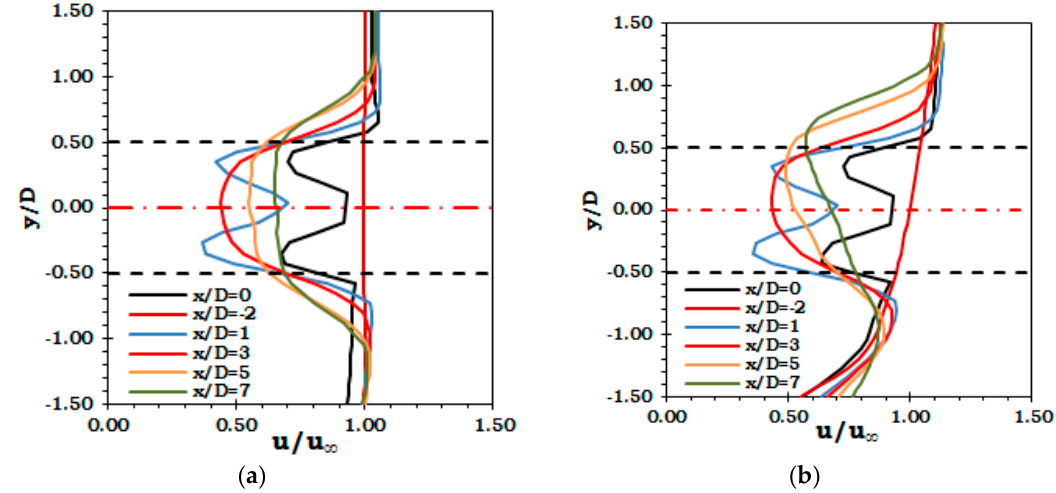
Figure 10. Axial velocity (normalized by the free stream velocity) contour for ( a ) uniform inlet velocity; ( b ) velocity profile.